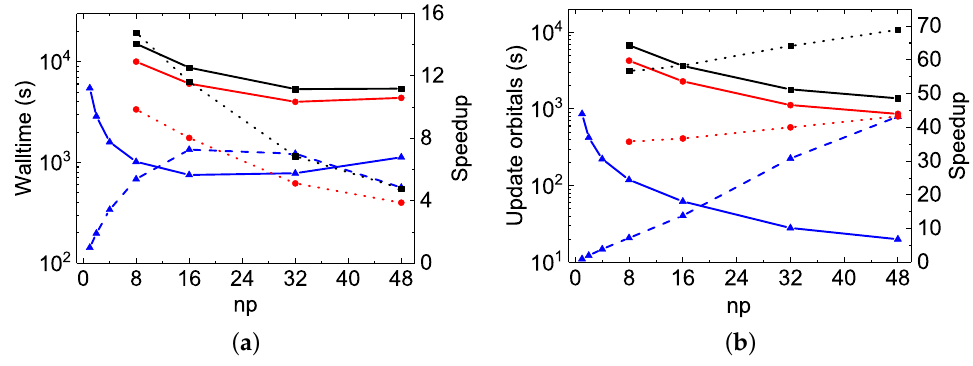
Figure 4. MPI performances of the codes for the Mg VII AS 5 -SCF calculations. ( a ) Solid lines (left y axis): walltimes (in s) for rmcdhf_mpi (squares), rmcdhf_mem_mpi (circles) and rmcdhf_mpi_FD (triangles) codes versus the number of MPI processes ( np ). Dashed line (right y axis): speed-up factors for rmcdhf_mpi_FD (triangles) calculated as the ratios of T ( np = 1 ) to others. Dotted lines (right y axis): speed-up factors for rmcdhf_mpi_FD relative to rmcdhf_mpi (squares) and to rmcdhf_mem_mpi (circles), respectively. ( b ) Solid lines (left y axis): orbital updating CPU times ( T in s) for rmcdhf_mpi (squares), rmcdhf_mem_mpi (circles) and rmcdhf_mpi_FD (triangles) calculations. Dashed line (right y axis): speed-up factors (triangles) for rmcdhf_mpi_FD estimated from the ratios of T ( np = 1 ) to others. The second “Update” times given in Table 3 are shown here. Dotted lines (right y axis): speed-up factors of rmcdhf_mpi_FD relative to rmcdhf_mpi (squares) and to rmcdhf_mem_mpi (circles),